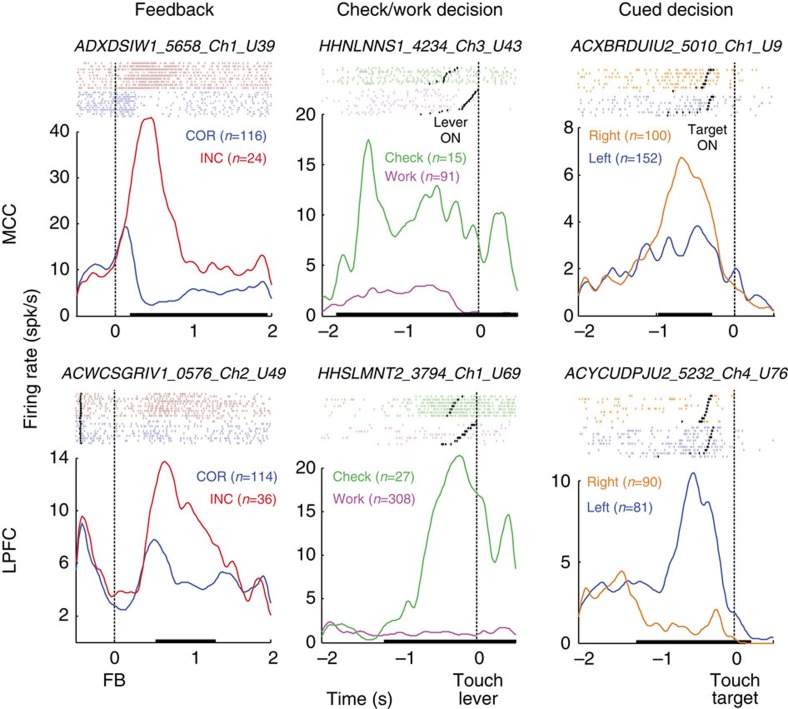
Typical examples of single unit activity.Average firing rates and rasters for six different single unit activities in MCC (top) and LPFC (bottom) discriminating either between negative/positive feedback (left), Check versus Work decisions (middle) and Cued decisions in the main task (right). Black lines on time axis highlight the time period where the difference in firing rate is significant (KW test, P<0.01). Only subsets of trials are displayed (n represents the total number of trials).